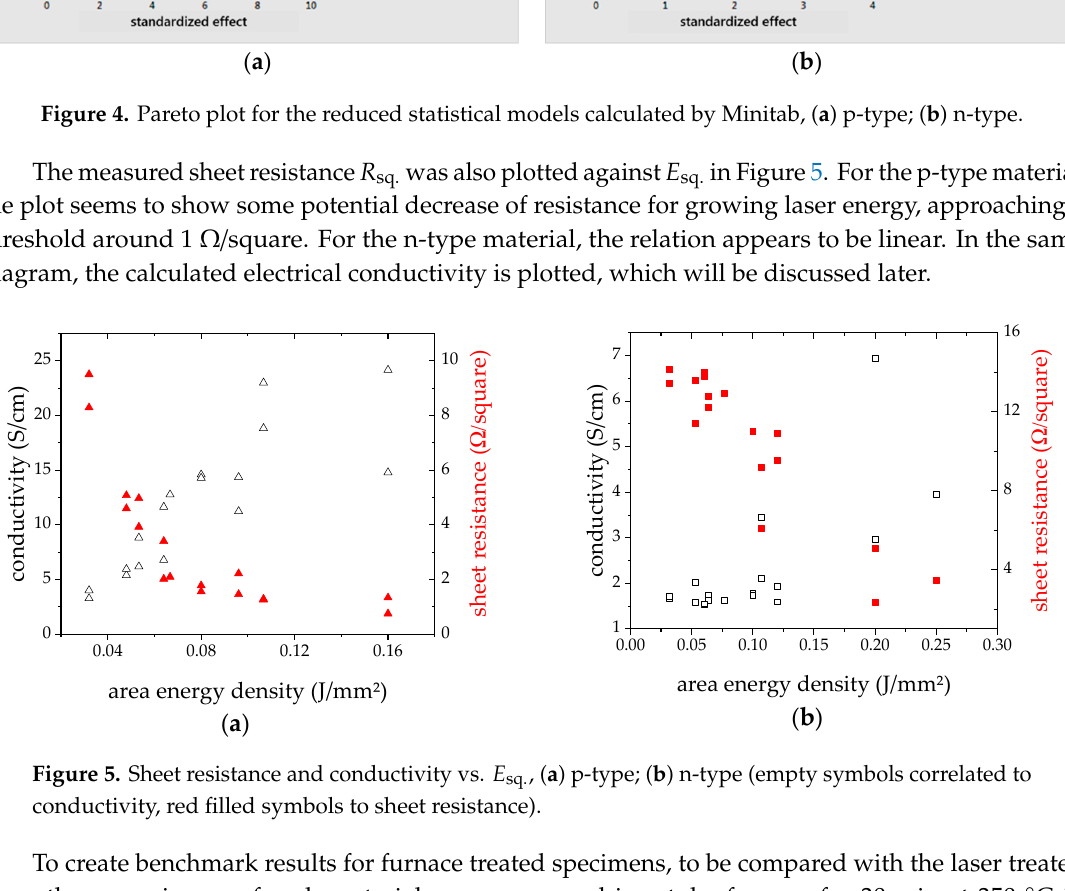
Table 4. Electrical characterization of furnace processed layers.